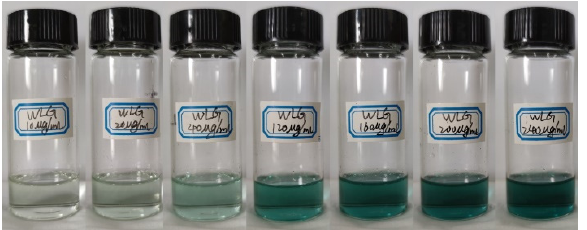
Figure 2. Welan gum solutions with different concentrations (from left to right: 10 μ g/mL, 20 μ g/mL, 40 μ g/mL, 80 μ g/mL, 120 μ g/mL, 160 μ g/mL, 200 μ g/mL, and 240 μ g/mL) after chromogenic reaction.